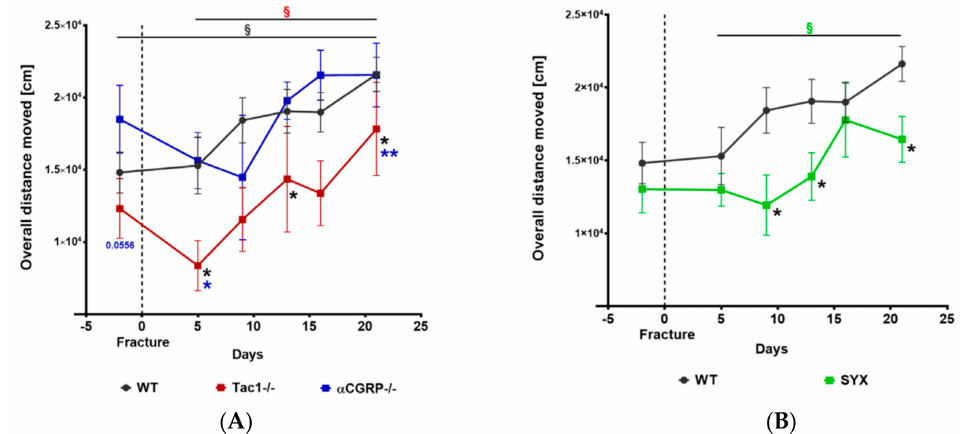
Figure 1. Time course of locomotion analysis before and after fracture. Nightly locomotion of Tac1 − / − , α -CGRP − / − ( A ), SYX ( B), and WT ( A , B ) mice before and after fracture was analyzed during a 1 h time span in separate cages. Overall distance moved was monitored with the EthoVision XT 9 Software. Data are expressed as mean ± SEM. § indicates significance within the respective groups, demonstrated by the respective color. * in black indicate di ff erences between neurotransmitter deficient mice and WT animals. * / ** / p -Values in blue indicate di ff erences between Tac1 − / − and α -CGRP − / − mice. * = p ≤ 0.05; ** = p ≤ 0.01. N (sample number) =